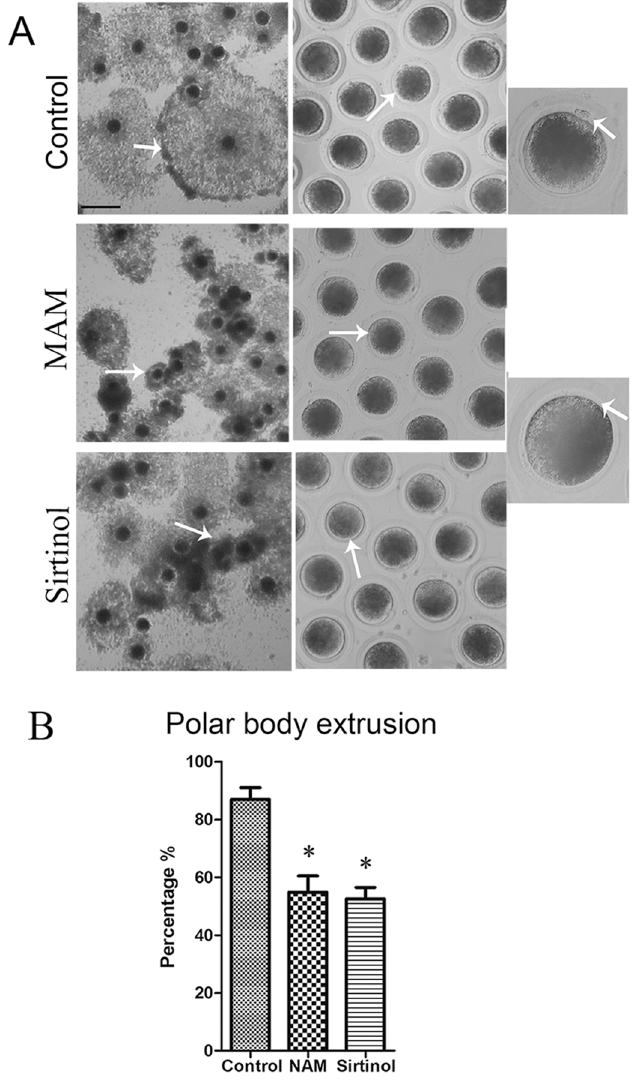
Fig 1. Treatment with nicotinamide (NAM) and Sirtinol affects meiotic maturation in porcine oocytes. (A) In cumulus-oocyte complexes (COCs), the peripheral layer of the cumulus expanded to more than 5 layers in the control group, whereas it became progressively thinner in the NAM- and Sirtinol-treated COCs. Most oocytes in the control group extruded the first polar body (indicated by white arrow). Upon treatment with NAM and Sirtinol, a large proportion of oocytes failed to extrude polar bodies. Bar = 100 μ m. (B) Rate of polar body extrusion in the control, NAM-, and Sirtinol-treated groups. Rate of polar body extrusion in treatment groups was significantly reduced comparing to control group. * , significant, p <